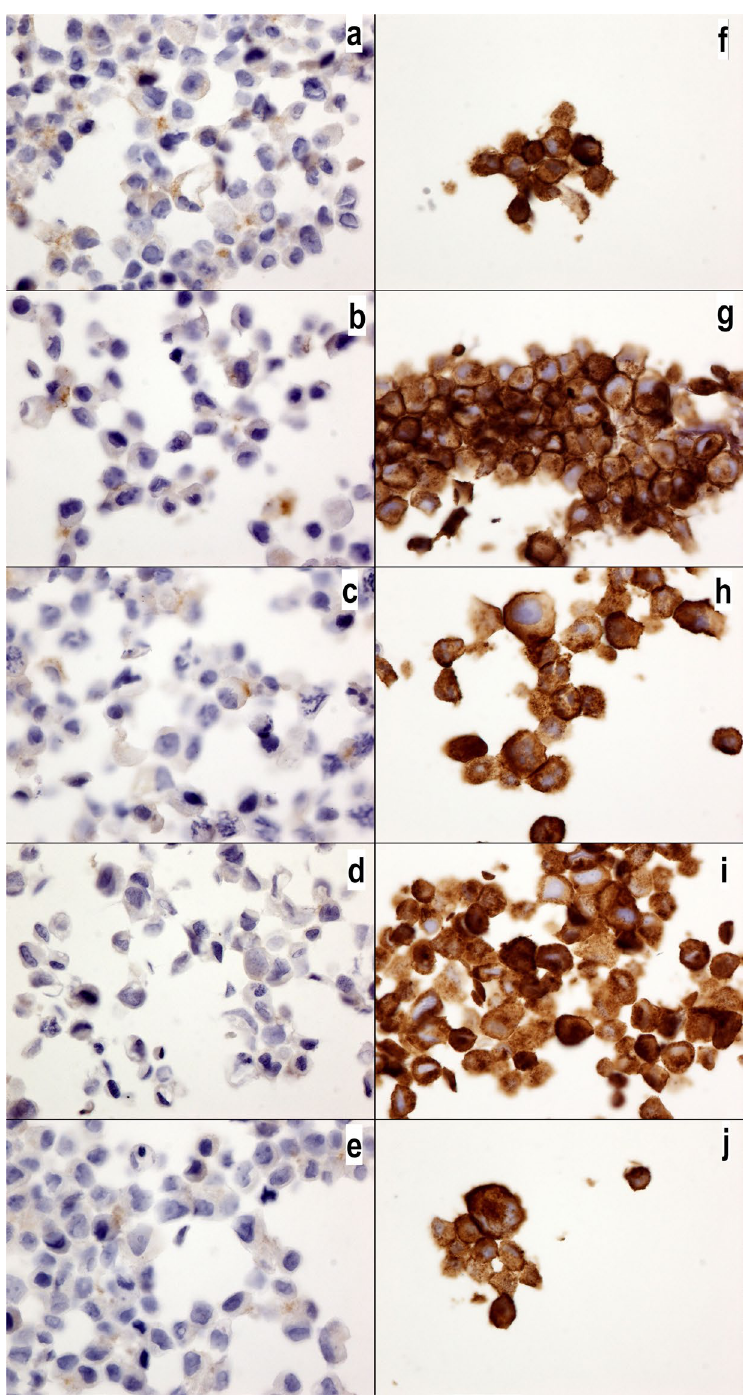
Figure 5. EGFR expression in MCF7 and MDA-MB231 cells. EGFR expression in MCF7 ( a – e ) and MDA-MB231 cells ( f – j ) without drugs or ( a , f ) with cyclophosphamide ( b , g ), doxorubicin ( c , h ), epirubicin ( d , i ) or 5-fluorouracil ( e , j ). Note the higher expression of EGFR in the MDA-MB231 cells than that in the MCF7 cells, but no changes were observed with the chemotherapy drug treatment. The EGFR antibody was diluted 1/200 (40x